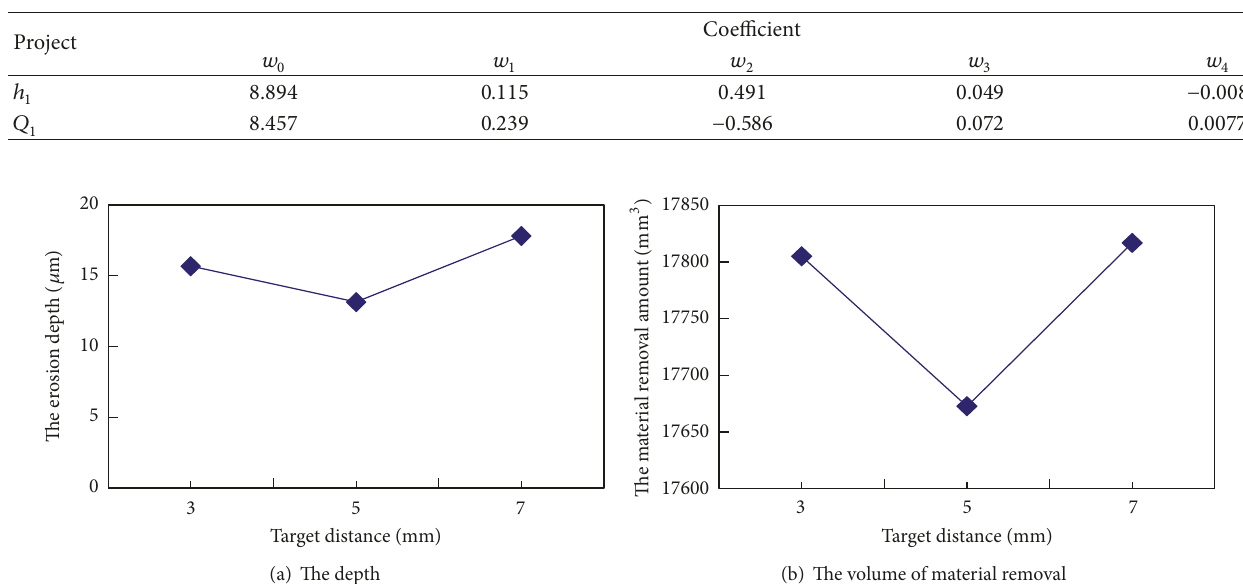
Figure 6: The effect of stand-off on the depth and the volume of material removal.